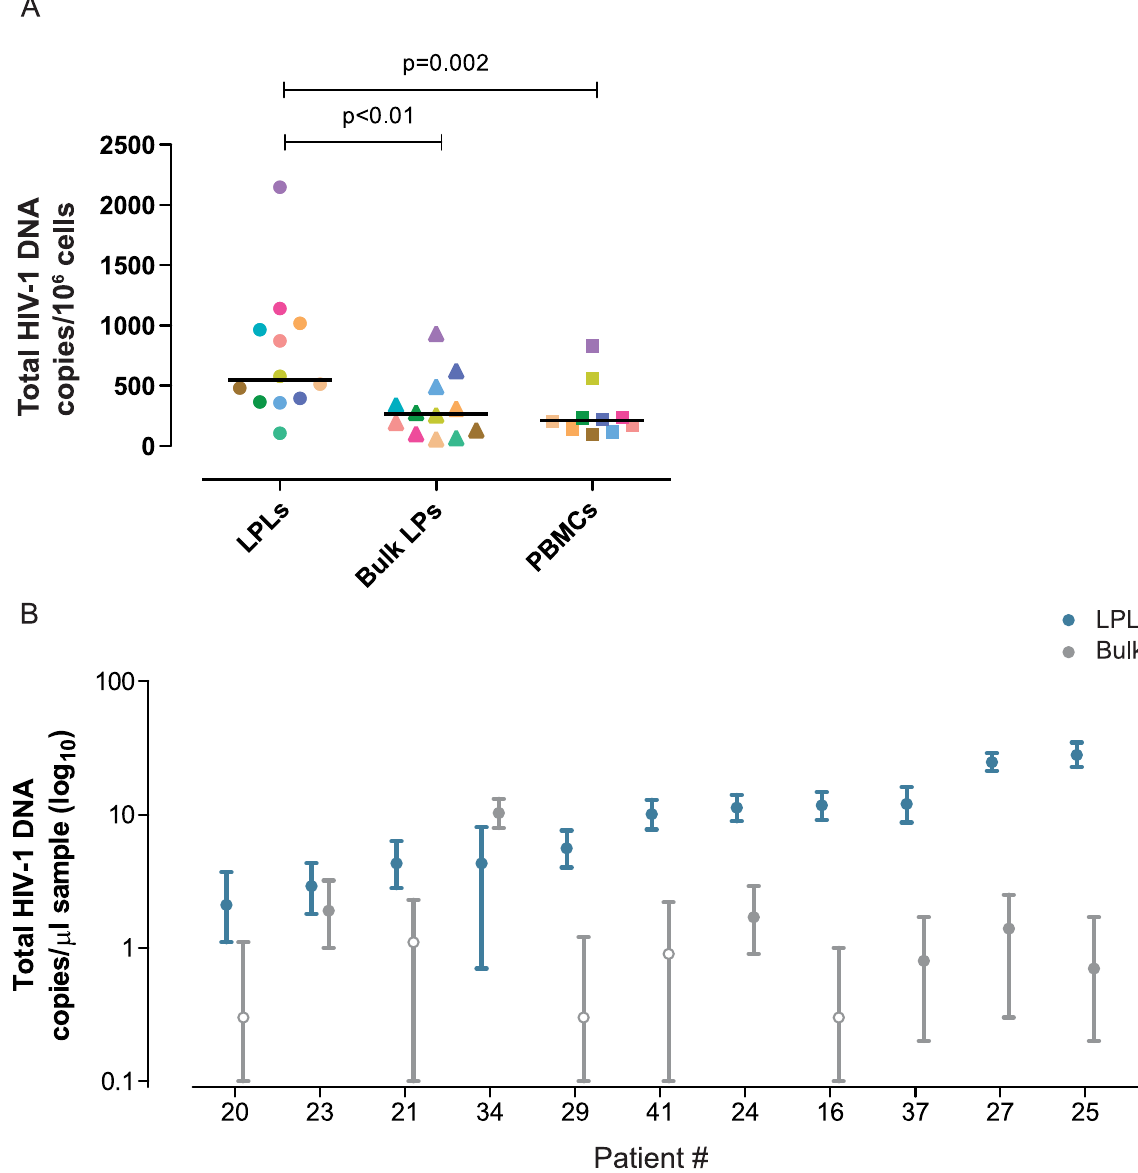
Fig 4. Total HIV-1 DNA quantification by ddPCR. (A) Comparison of total vDNA quantification from LPLs, bulk LPs and PBMCs. (B) Comparisonof raw absolutevDNA quantification with Poisson 95% intervals from LPLs and bulk LPs. Clear dots represent the quantifications with the minimumPoisson 95% intervalunder the limit of detection. Statistically significantp values are showed(Wilcoxon signed rank test).